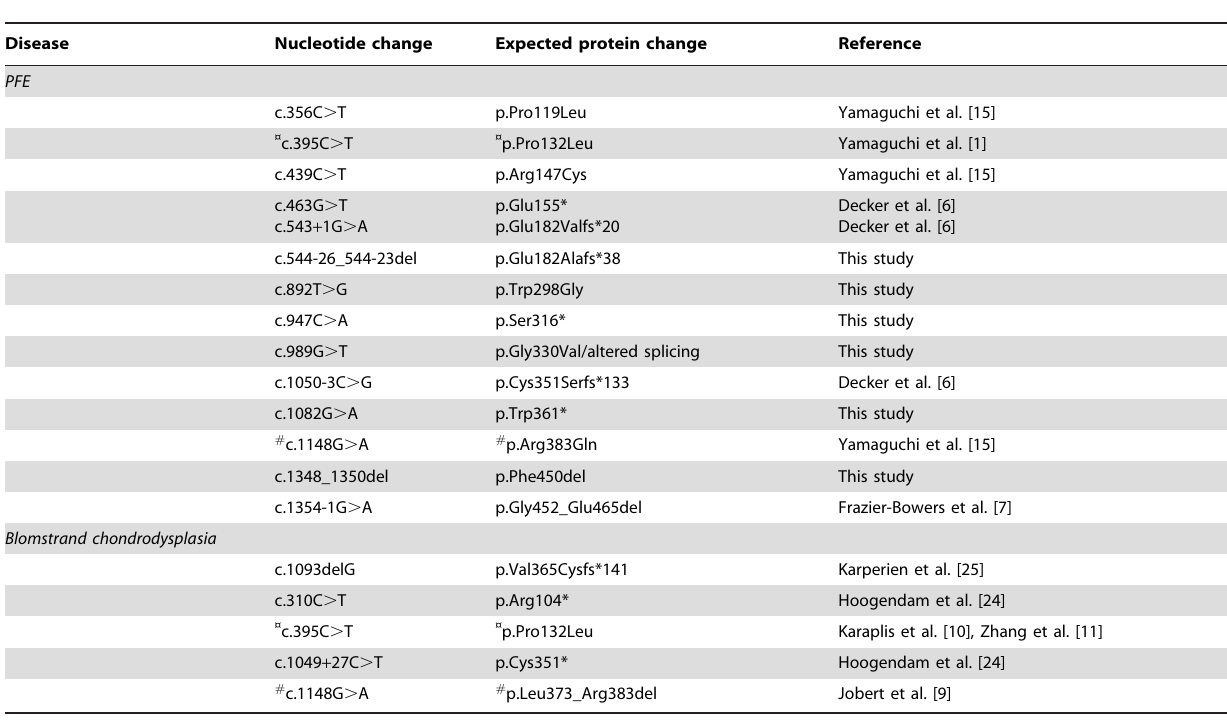
Table 2. Summary of mutations in Blomstrand chondrodysplasia and PFE patients.